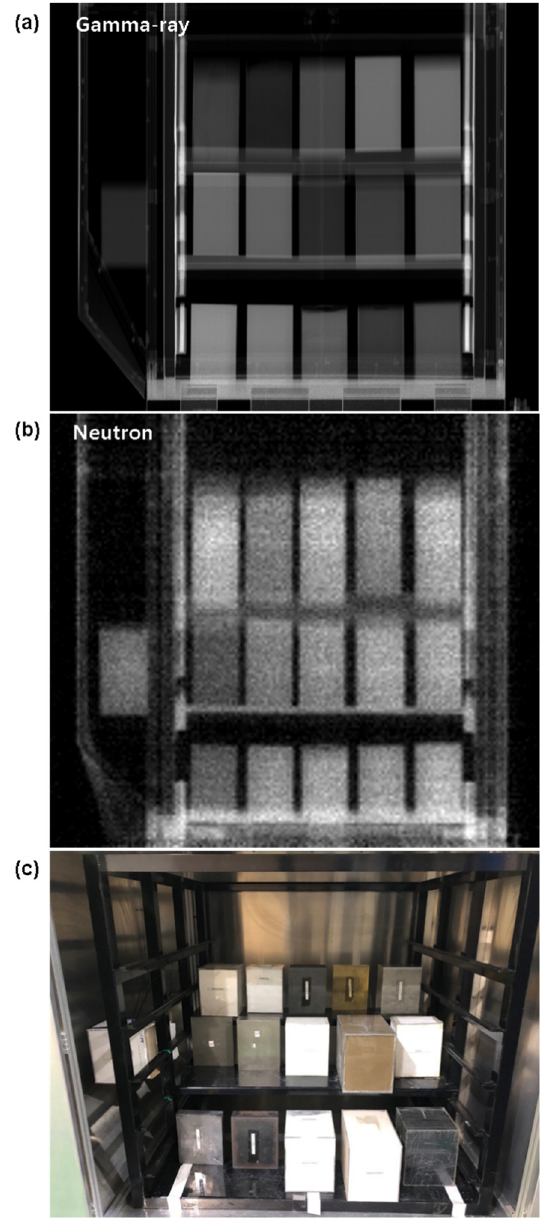
Figure 7. ( a ) Gamma-ray and ( b ) neutron image results of ( c ) material samples arranged in the air cargo container.